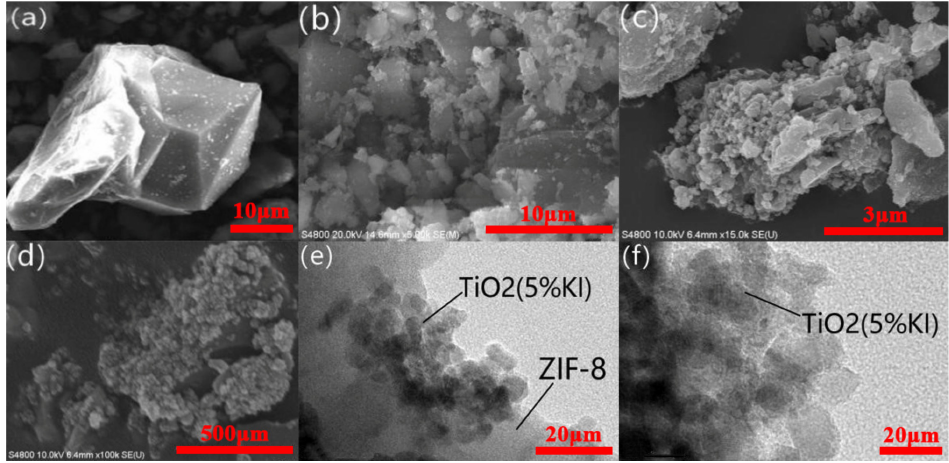
Figure 2. SEM ( a ) of ZIF-8; SEM ( b – d ) and TEM ( e , f ) of ZIF-8@TiO 2